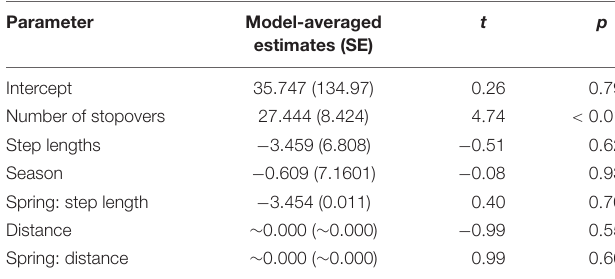
TABLE 3 | Weighted estimates of parameter values from the selection analysis on modeling the duration of migrations.